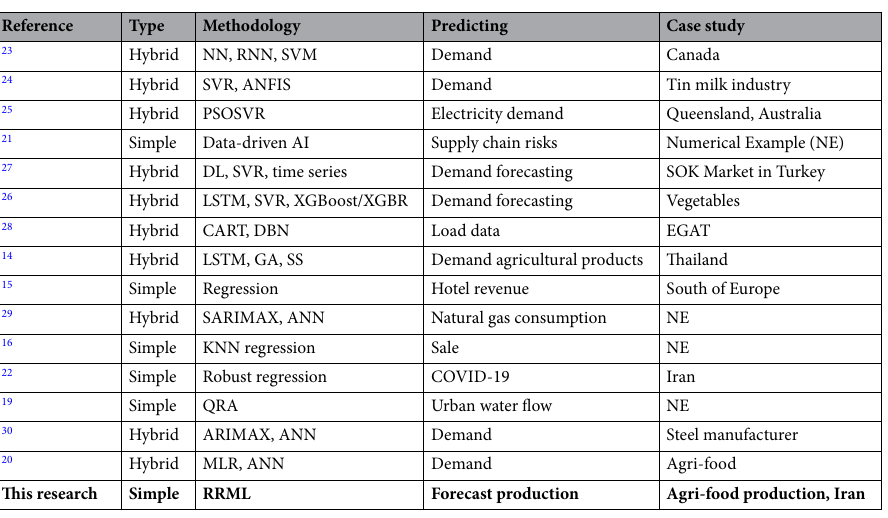
Table 1. Related works. Significant values are in